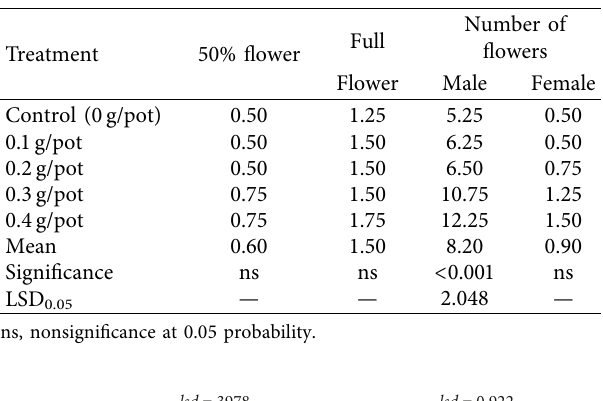
Table 1: Influence of Trichoderma -based biofertilizer on days to 50% flower, days to full flower, and number of flowers.